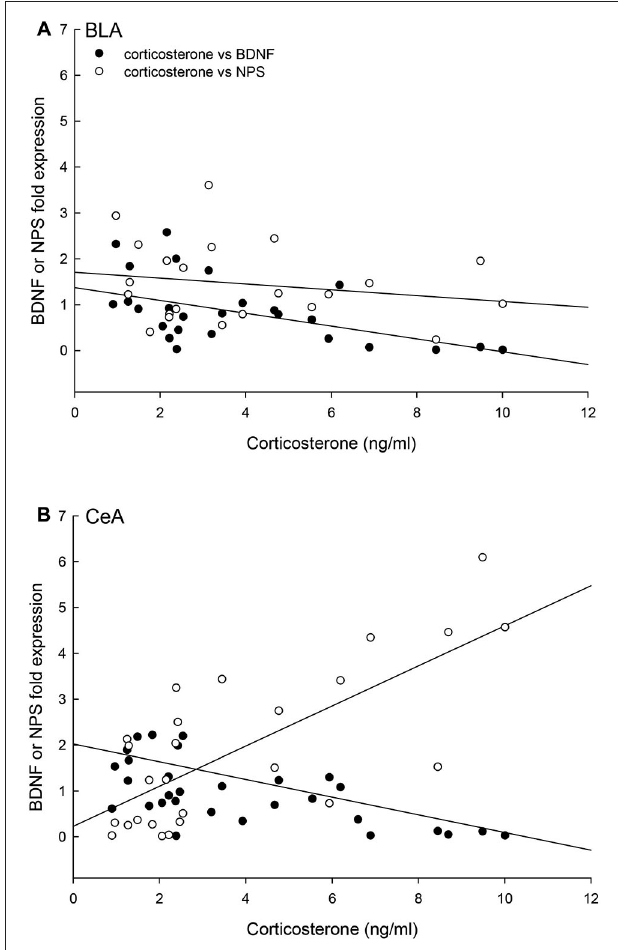
FIGURE 9 | Concentrations of corticosterone, BDNF and NPS gene expression are correlated. (A) In the BLA, the individual (Control N = 14; No Aggression N = 7; Escape N = 8; No Escape N = 8) corticosterone, BDNF mRNA, and NPS mRNA concentrations are correlated (multiple regression analysis r 2 = 0.43, p < 0.005; 3D regression analysis r 2 = 0.20, p < 0.12); with a negative regression for BDNF and corticosterone ( p < 0.002), no statistical relationship between NPS and corticosterone ( p > 0.05), and a trend toward a positive correlation between BDNF and NPS fold expression ( p < 0.098). (B) In the CeA, the individual (Control N = 14; No Aggression N = 7; Escape N = 8; No Escape N = 5) corticosterone, BDNF mRNA, and NPS mRNA concentrations are correlated in a three-dimensional relationship (multiple regression analysis r 2 = 0.62, p